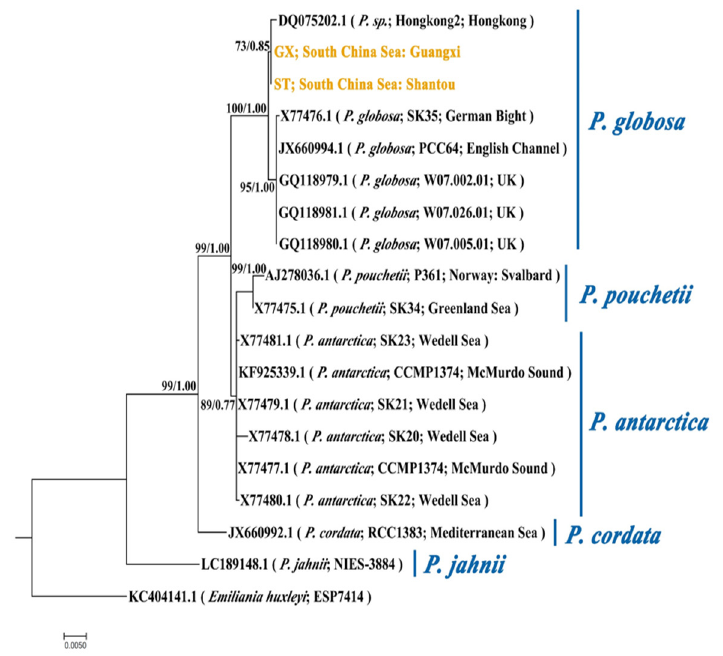
Figure 2. Phylogeny of Phaeocystis based on 18S rRNA sequences (1646 characters after data processing). The phylogenetic tree was inferred by the maximum likelihood (ML) method. Numbers at nodes represent the bootstrap values for the ML bootstrap analysis and Bayesian posterior probabilities. The strains in yellow are objects in this study. The scale bar indicates the number of nucleotide substitutions per site. ST represents the P. globosa collected in Shantou and GX represents the P. globosa collected in Guangxi.